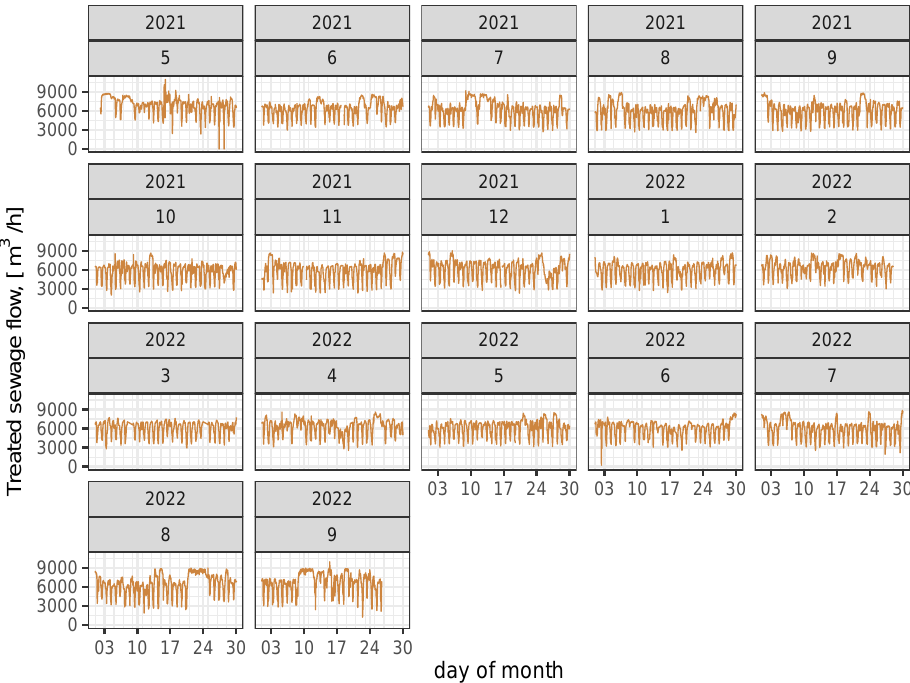
Figure 5. Flows of treated wastewater at the exit from the treatment plant for the selected months in which the measurements were carried out.